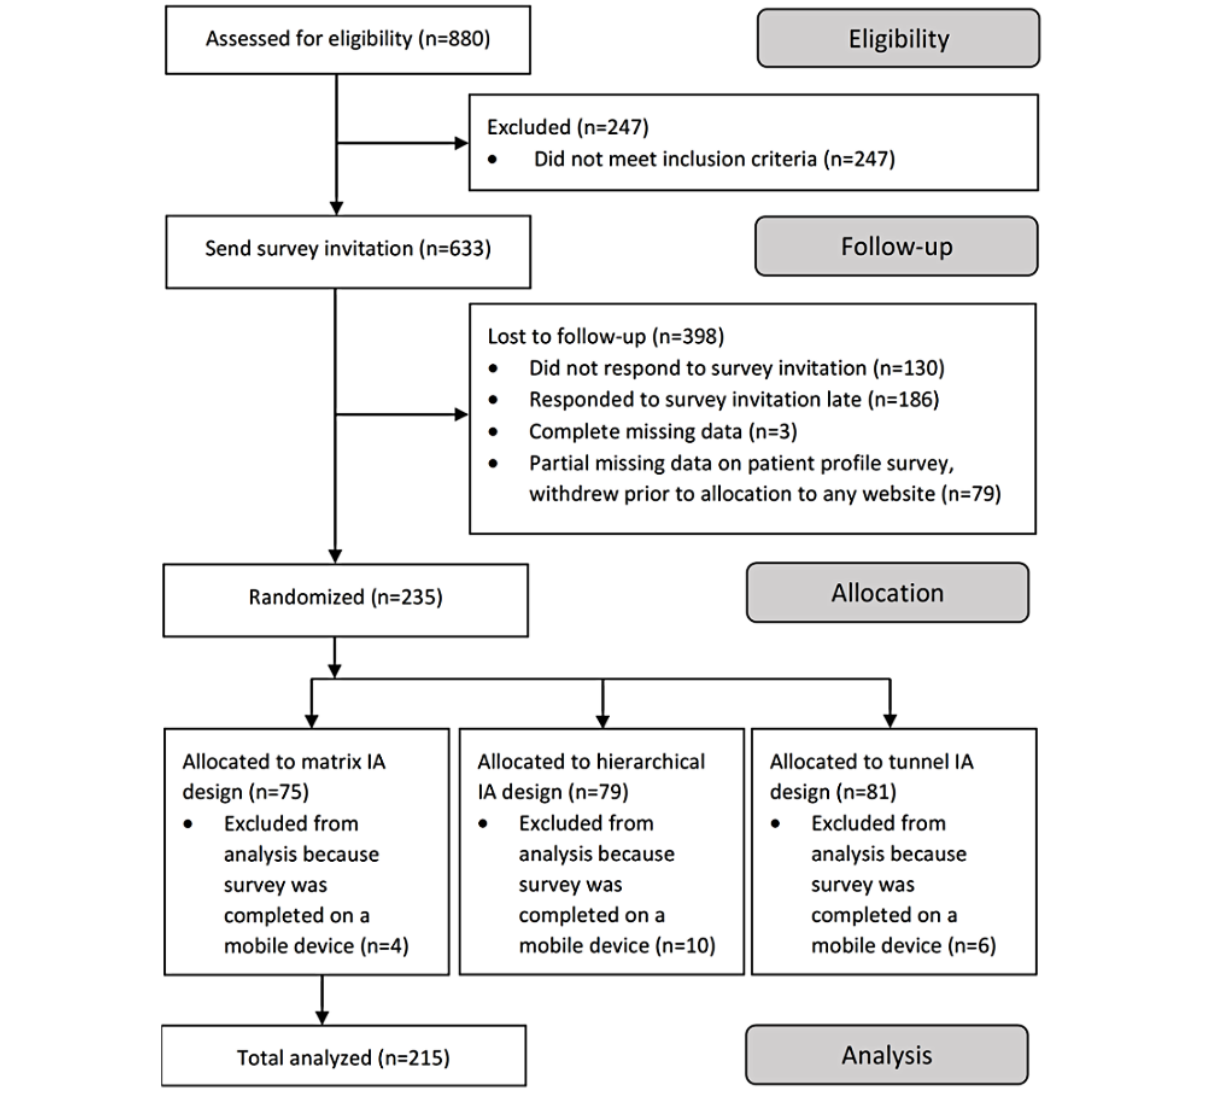
Figure 3. Participant recruitment and follow-up diagram. IA: information